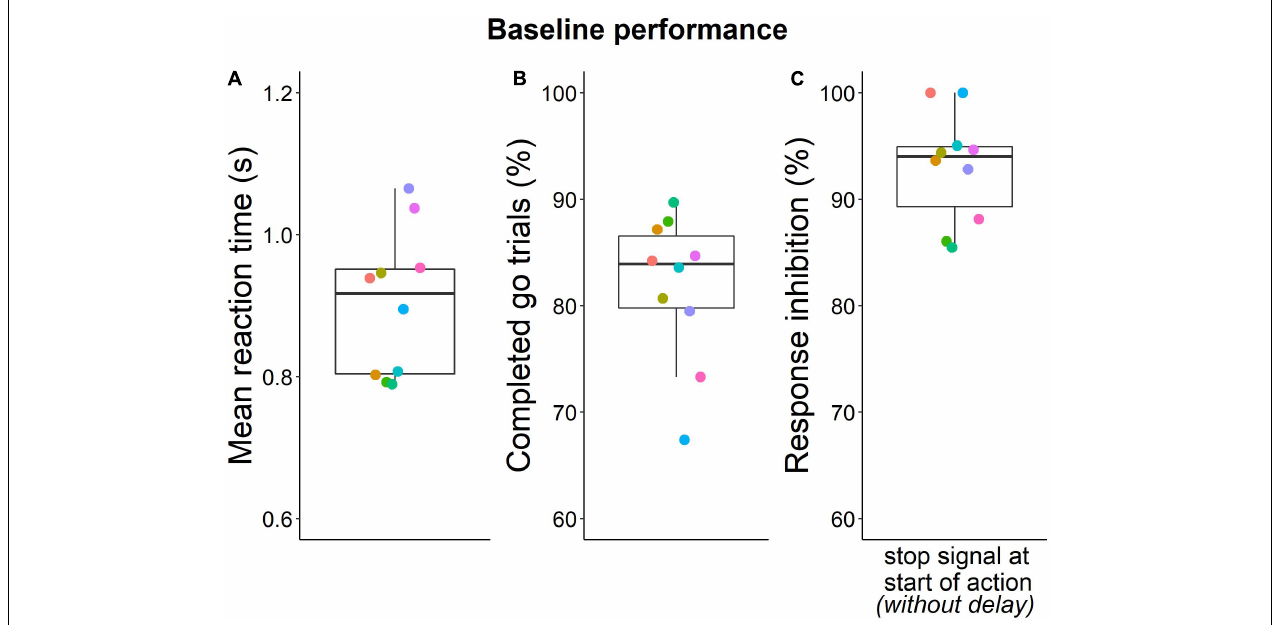
FIGURE 3 | Baseline performance during last training day. (A) Mean go response reaction times (median = 0.92 s). (B) Percentage of successfully completed go trials (median = 84%). (C) Inhibition performance during baseline stop trials (no stop signal delay) (median = 94%). Individuals are represented by the same color in all panels. Box plots show median, 1st and 3rd quartile, and whiskers the 1.5 interquartile range. Data from n = 10 mice.